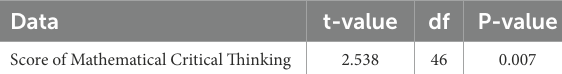
TABLE 9 Independent sample t -test